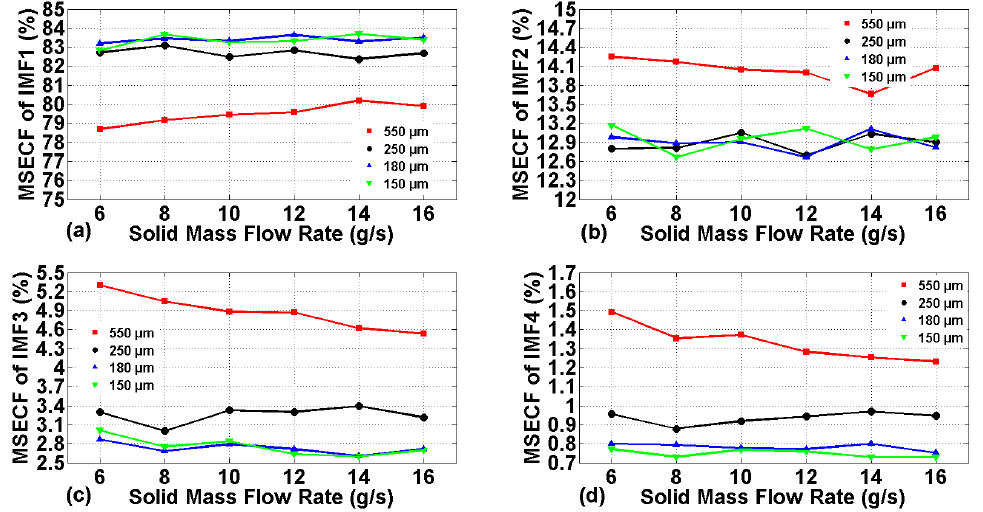
Figure 14. Relationship between the mean-squared error contribution fraction (MSECF) for the IMFs and the particle flow rate for different particle sizes.